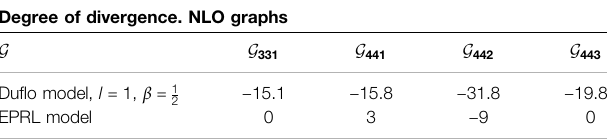
TABLE 7 | Degree of divergence for the diagrams in Figure 3 computed from the power counting formula Equation 3.27. Degree of divergence. NLO